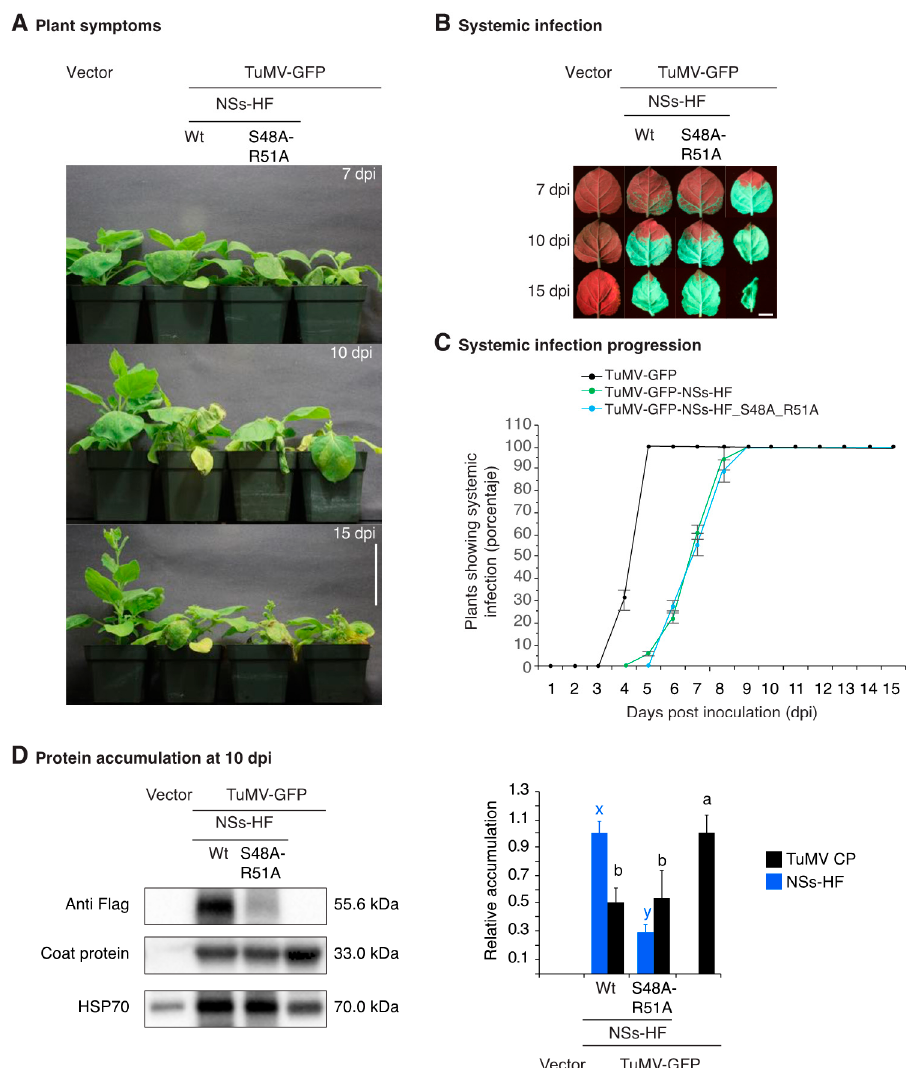
Figure 5 . Symptoms, virus distribution and accumulation in noninoculated leaves of N. benthamiana . Plants were inoculated by agroinfiltration with empty vector, TuMV-GFP, or TuMV-GFP derivative expressing active or suppressor-deficient NSs-HF. ( A ) Representative plant symptoms at 7, 10 and 15 dpi. Scale bar: 7.5 cm. ( B ) Noninoculated leaves from plants in ( A ) showing representative distribution of virus infection determined by GFP fluorescence under UV light. Scale bar: 2 cm. ( C ) Proportion (%) of plants showing systemic infection as determined by UV illumination. Points represent average ( ± standard error) of three repetitions, each consisting of 18 plants per treatment. ( D ) Virus accumulation in systemically infected leaves at 10 dpi. Representative western blots showing NS-HF and coat protein accumulation in the same sample. HSP70 was used as a loading control. The histogram shows average ( ± standard error) coat protein and NSs-HF accumulation (four biological replicates) relative to TuMV-GFP or to wt NSs-HF, respectively. Bars with the same letter do not significantly differ (Tukey’s test with α = 0.05).